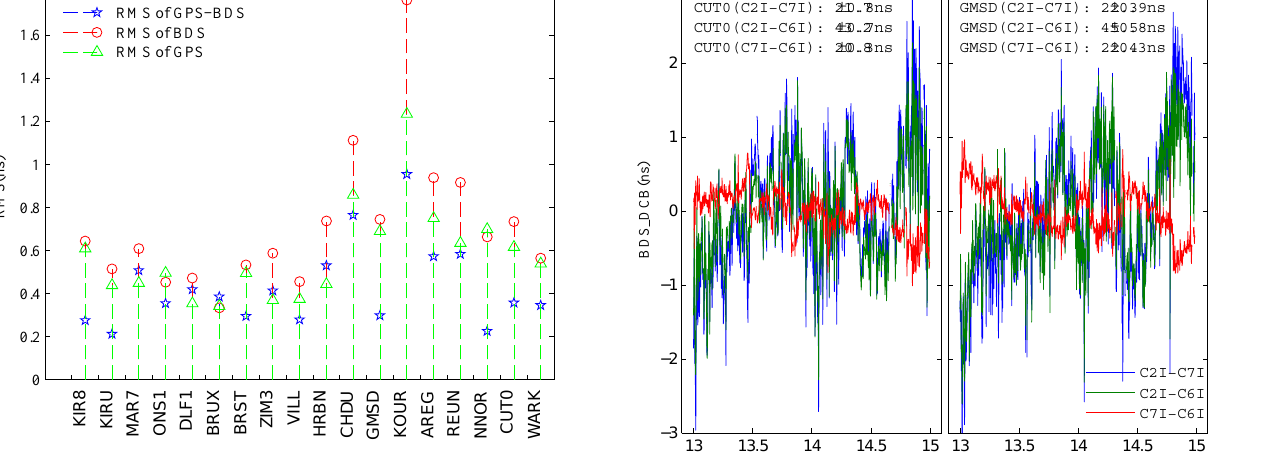
Figure 11. BDS receiver DCB variations in C2I–C7I, C2I–C6I, and C7I–C6I at BDS stations CUT0 and GMSD during